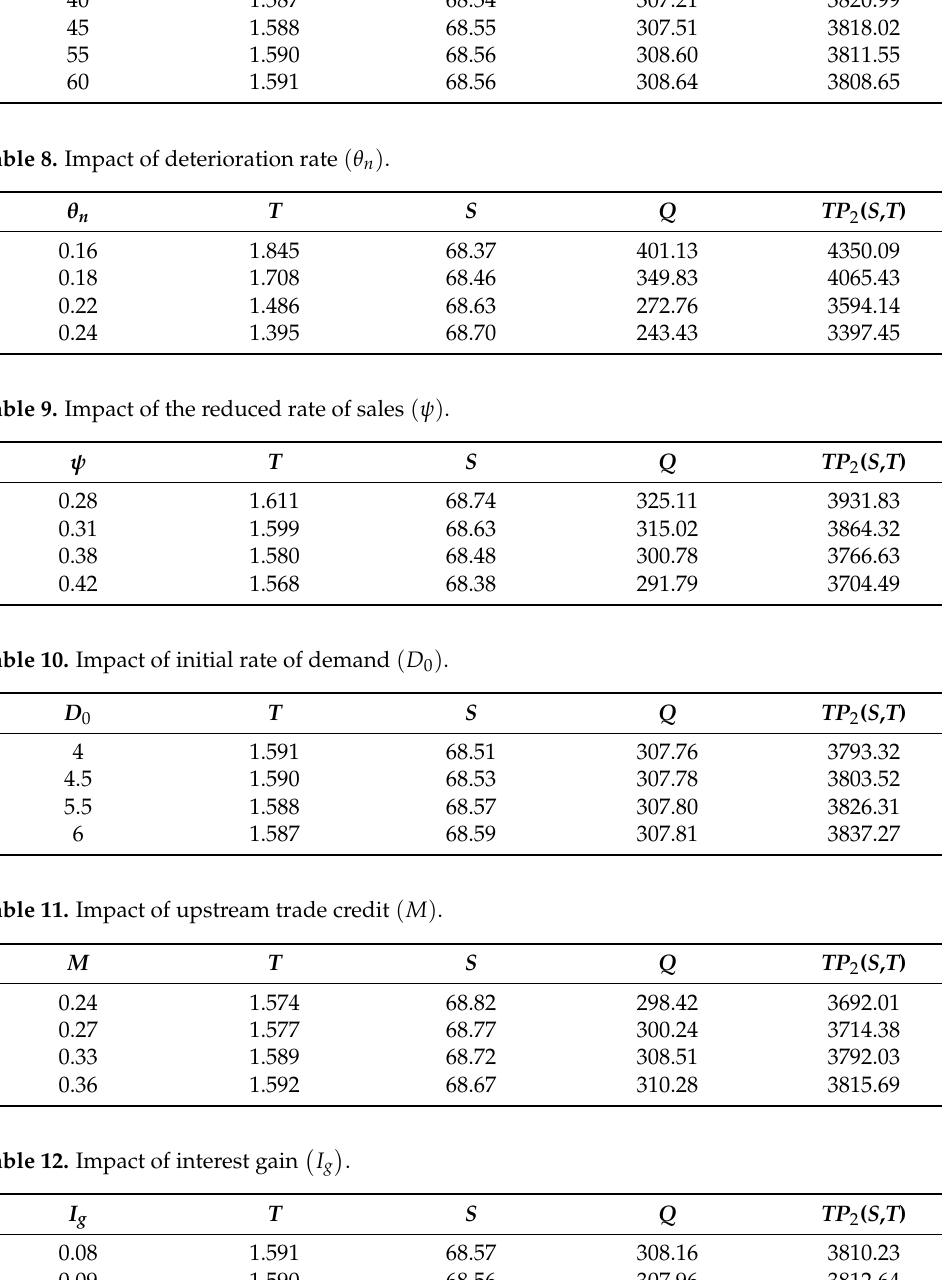
(cid:0) (cid:1) I p